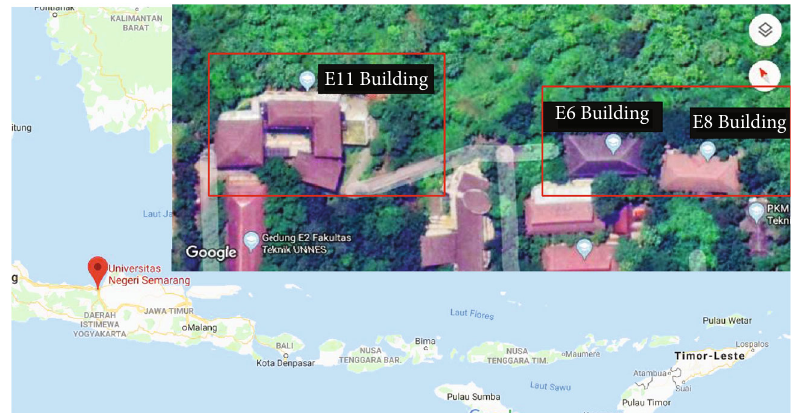
Figure 1: Detail location and building of the project site